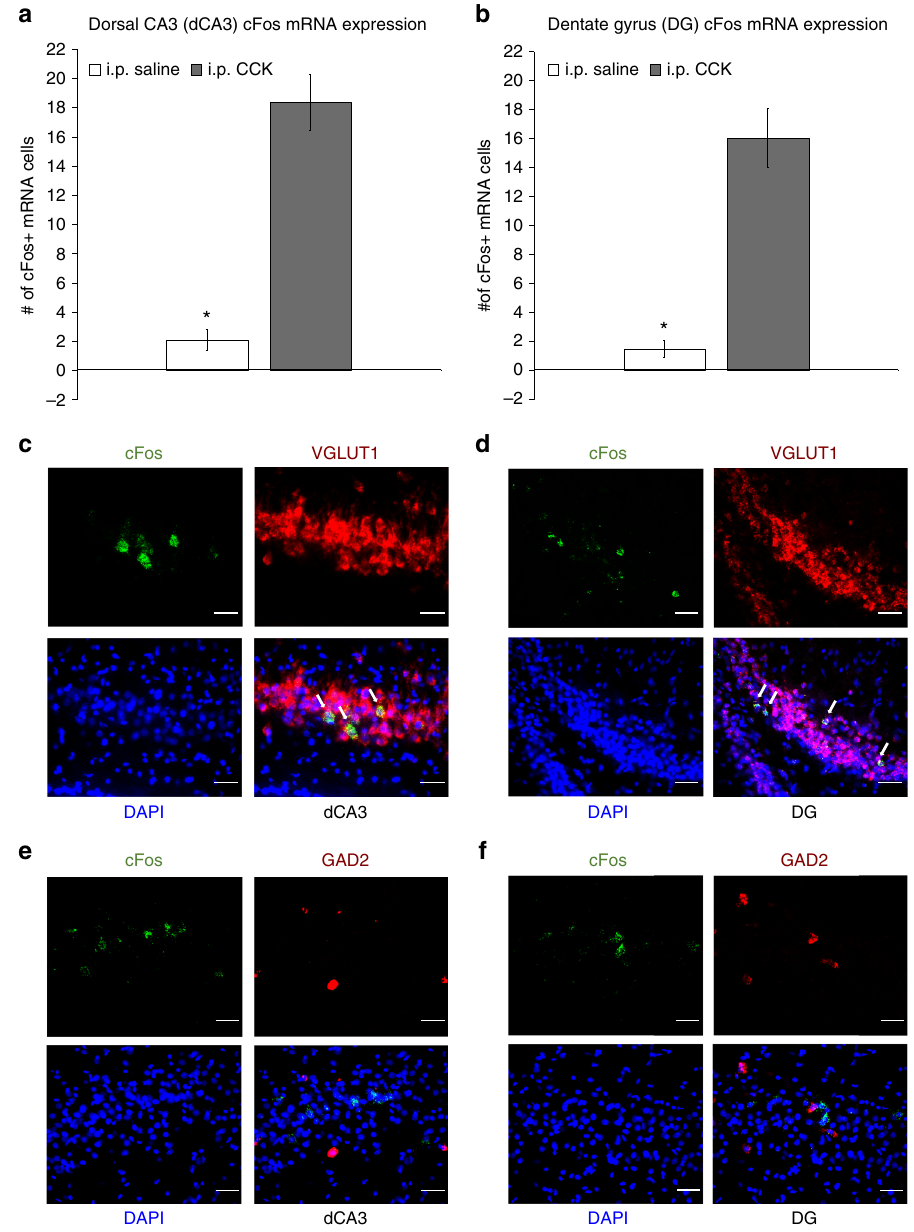
Fig. 5 Peripheral administration of CCK activates c-Fos mRNA expression in dCA3 and DG hippocampal glutamatergic neurons. Number of c-Fos-labeled (c-Fos + ) cells for mRNA ( fl uorescent in situ hybridization) expressed in the a dCA3 and b DG following i.p. administration of CCK ( n = 6) or saline ( n = 5) (ANOVA, F[1,9] = 53.093, p = 0.000046 (dCA3), F[1,9] = 40.496, p = 0.000131 (DG)). Approximately 93% and 94% of c-Fos + cells in the dCA3 and DG were VGLUT1 + (respectively) following i.p. CCK treatment, whereas only 4% and 8% of c-Fos + cells in the dCA3 and DG were GAD2 + (respectively) following i.p. CCK. c , d Representative images show c-Fos mRNA (green) and VGLUT1 (red) or GAD2 ( e , f ) (red) mRNA expression in dCA3 ( c , e ) and DG ( d , f ) cell bodies following i.p. CCK (DAPI nuclear stain; blue). Scale bar: 25 μ m. (Arrows, co-expression of c-Fos/VGLUT1 mRNA cells; * P < 0.05 vs i.p. saline controls; data are mean ± SEM. CCK cholesystokinin, dCA3 dorsal CA3, DG dentate gyrus, i.p.